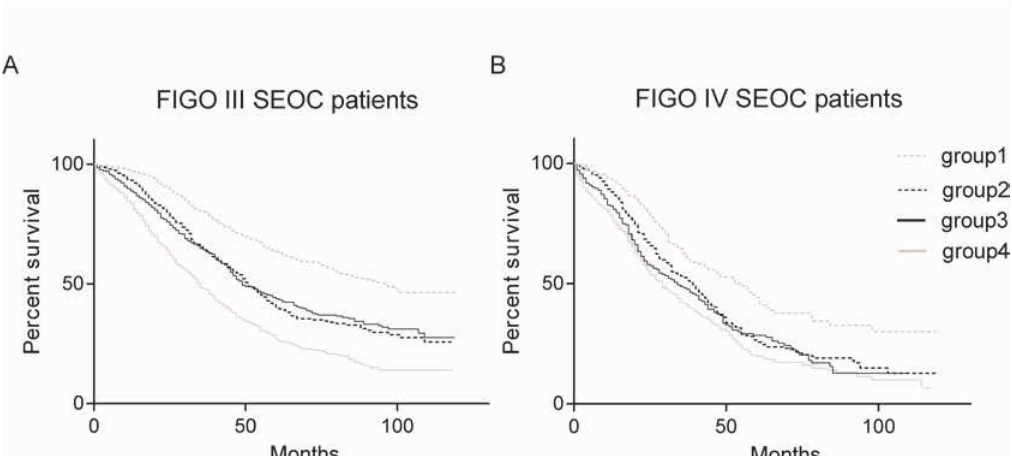
Figure 2. The Kaplan-Meier curve of LNR on overall survival by age (groups of age<60 and age≥60) for stage-III patients(A). The Kaplan-Meier curve of LNR on overall survival by age (groups of age<60 and age≥60) for stage-IV patients (B). (group1: age<60 and LNR<42%; group2: age<60 and LNR≥42%; group3: age≥60 and LNR<42%; group4: age≥60 and LNR≥42%) Table 2: Univariate and multivariate Cox proportion hazards regression analysis. Univariate analysis Multivariate Stage No. (%)